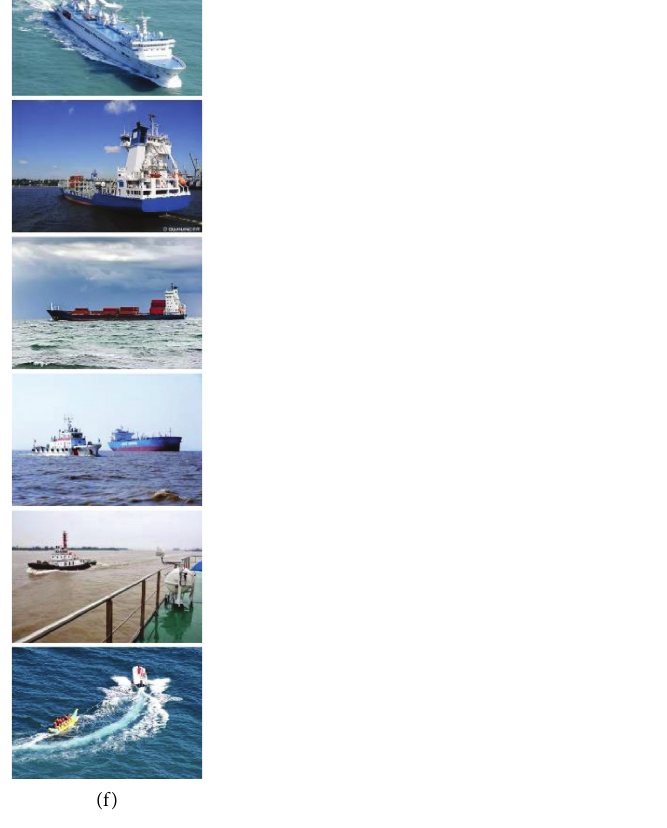
Figure 7: Visual comparisons of synthetic experiments on six images with transmission value � 0.3 and atmospheric light value � 0.8. From left to right: (a) synthetic haze image and dehazed images generated by (b) DCP [23], (c) RIVD [30], (d) MSCNN [12], (e) ours, and (f) original clear images,